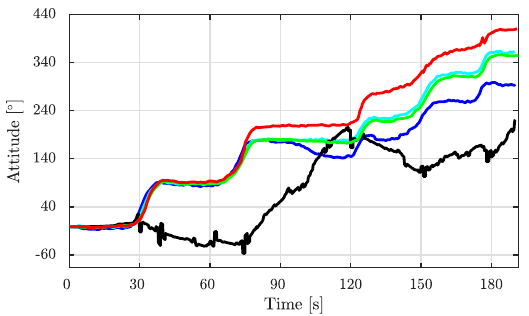
Figure 4. Estimated and reference cart attitude: GNSS-only solution (black), RGB-D-only solution (green), GNSS/RGB-D combination (red), GNSS/RGB combination (blue), reference (cyan). GNSS RGB-D